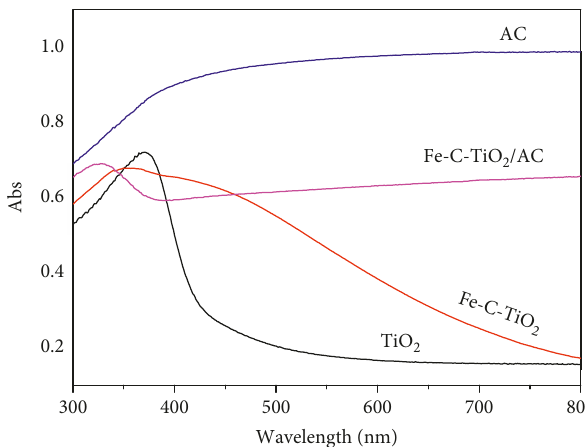
Figure 6: UV-Vis spectra of pure AC, Fe-C-TiO